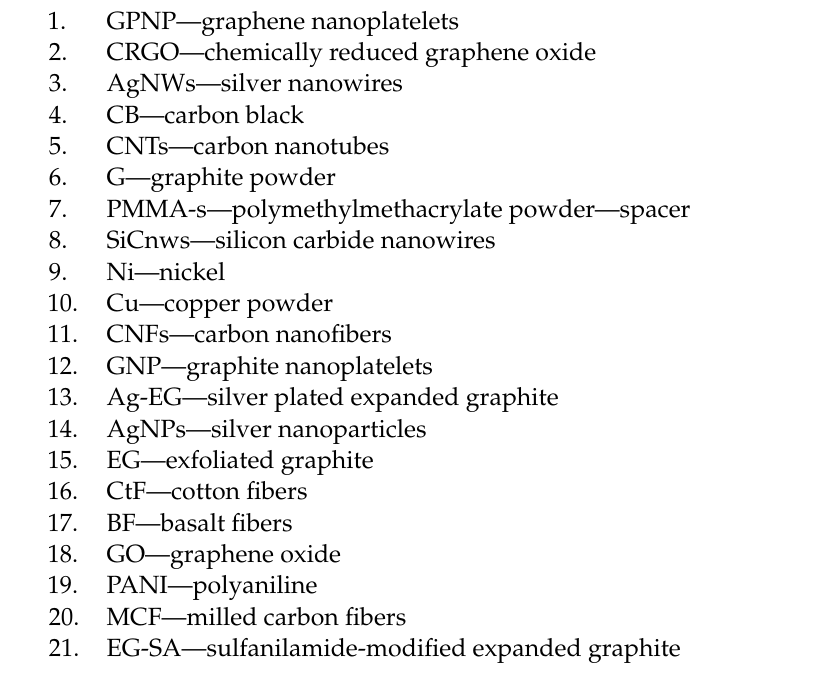
Table 1. Composition of the studied composites along with their conductivity results based on